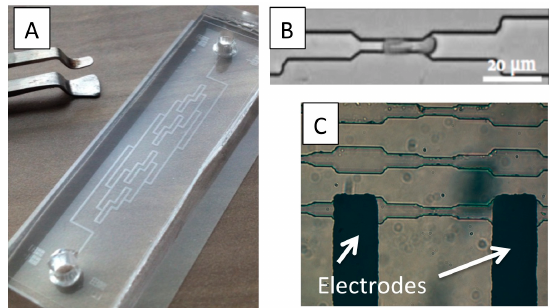
Figure 1. ( A ) Microfluidic chip; ( B ) RBC flowing within a capillary channel; ( C ) Electrodes integration for impedance